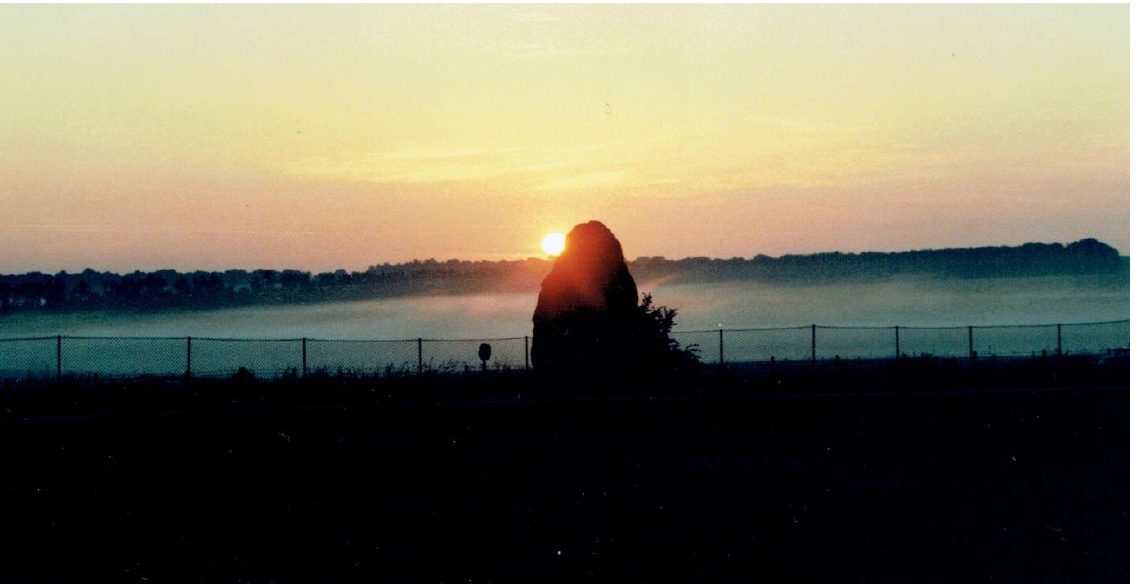
Figure 3. Reconstruction of how the Neolithic rising sun appeared when observed from ground level on the Stonehenge axis in the middle of the monument. The Heel Stone stands 4.7 metres high in its present leaning state. If restored to the vertical, it would stand nearer 5.2 m high (Atkinson 1978: 51-52). Photograph by the author.